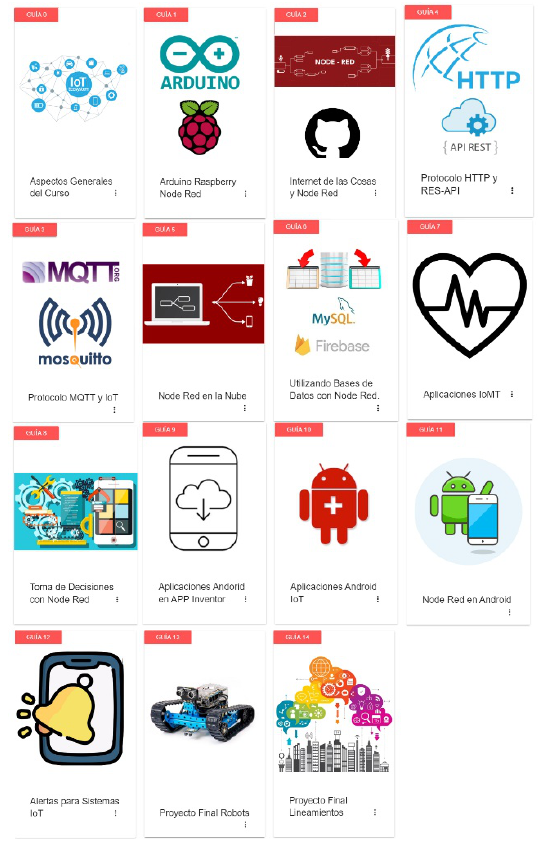
Figure 9. The users’ visualization of the subject Modules from Zero to Six.